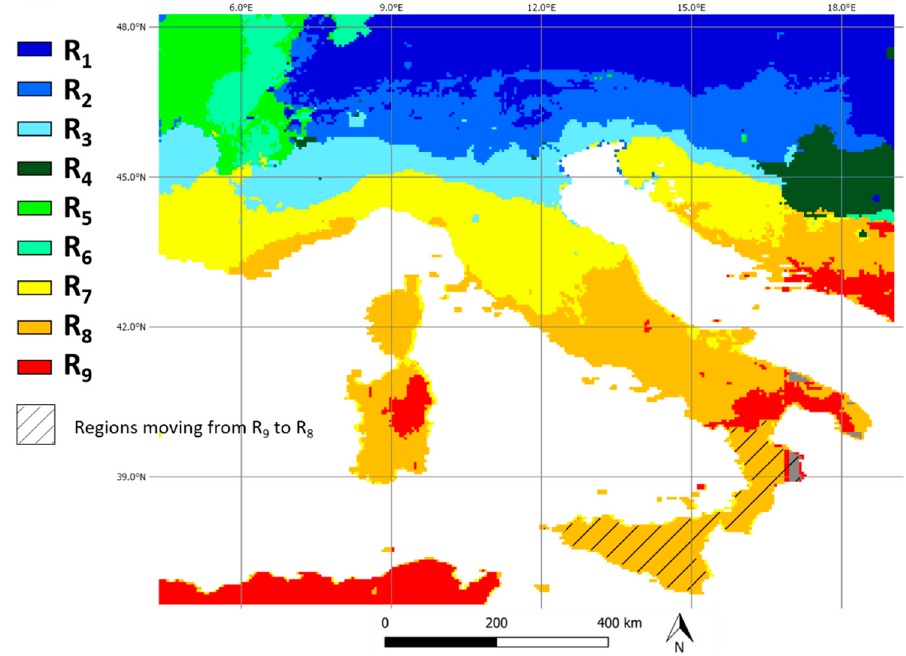
Figure 9. Analysis of precipitation projections: seasonal clusters, update of Figure 6. Hatched areas identify regions moving from R9 to R8.